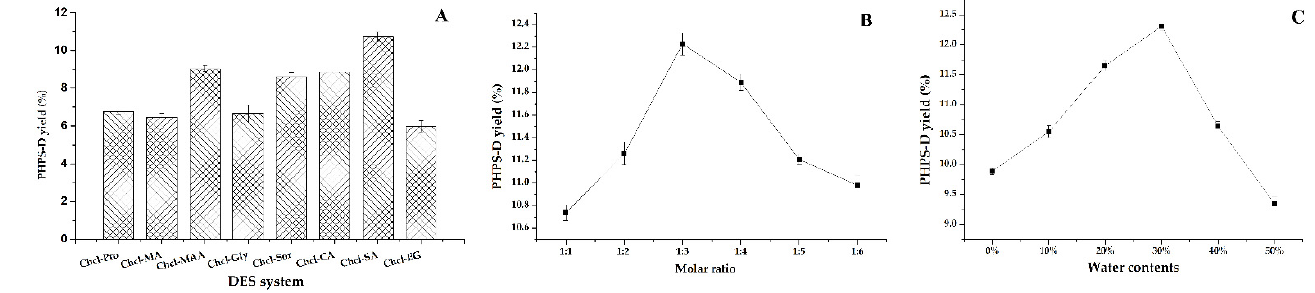
Figure 1. Effects of different DESs on the extraction of PHPS-D yield: ( A ) effect of the DESs systems on PHPS-D yield; ( B ) effect of molar ratio on PHPS-D yield; ( C ) effect of water contents on PHPS-D yield.